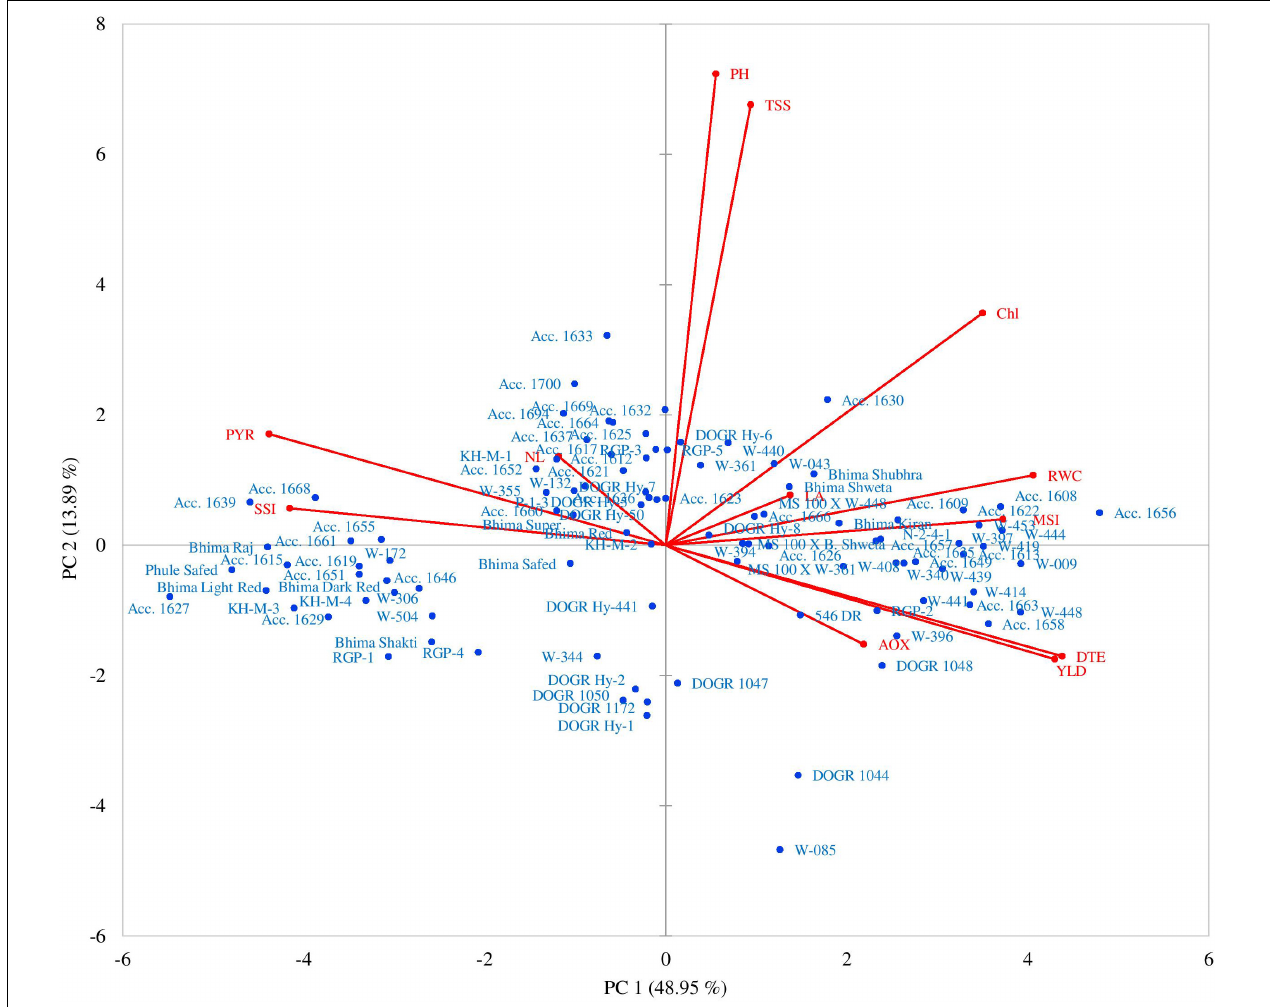
FIGURE 2 | Principal component biplots presenting grouping of 100 onion genotypes and distribution of different traits under drought